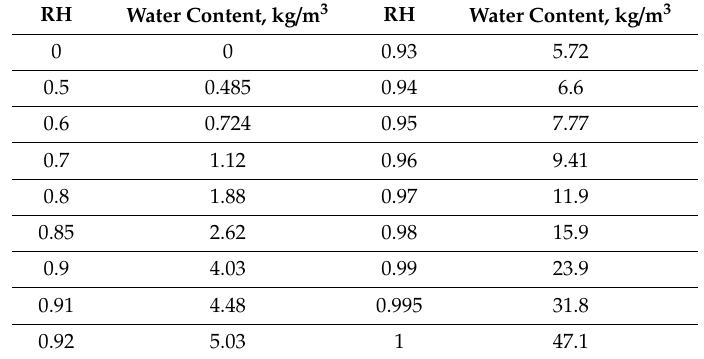
Table A2. Default water storage function (applies to vinyl with porosity = 1).